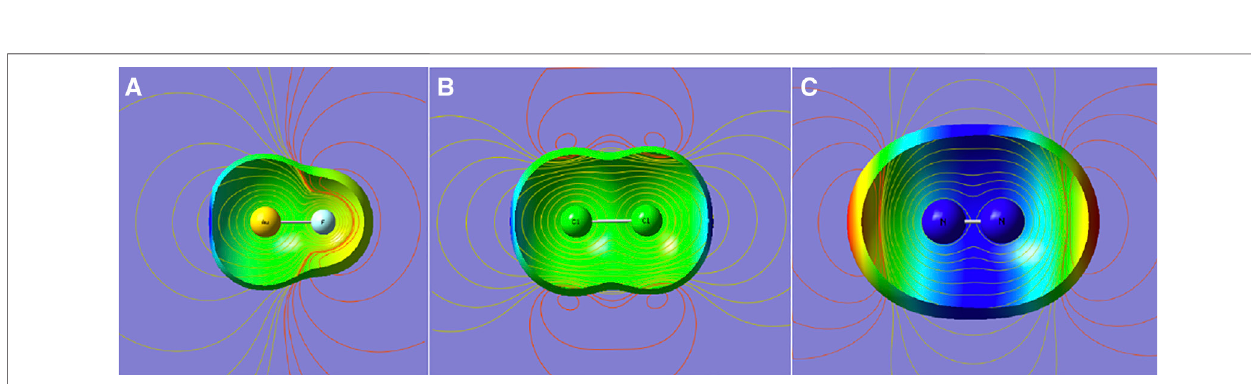
Frontiers in Chemistry |